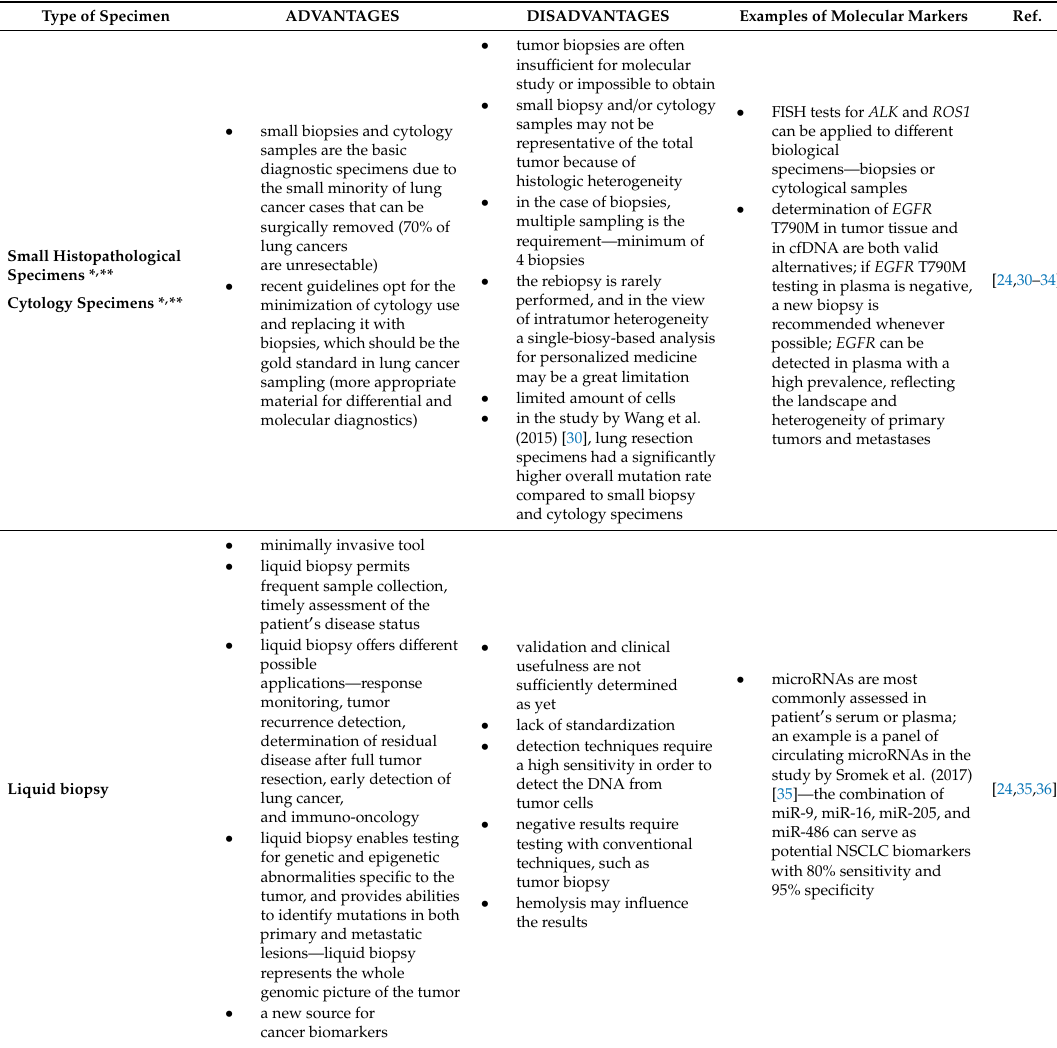
Table 1. Comparison of small histopathological and cytology specimens versus liquid biopsy. Type of Specimen ADVANTAGES DISADVANTAGES Examples of Molecular Markers